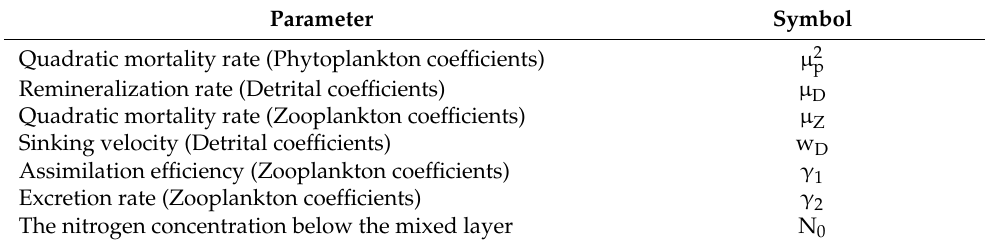
Table 1. Parameters in the NPZD model.